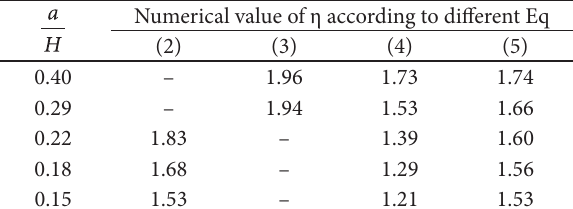
Table 1. Results of geometry factor calculation by different